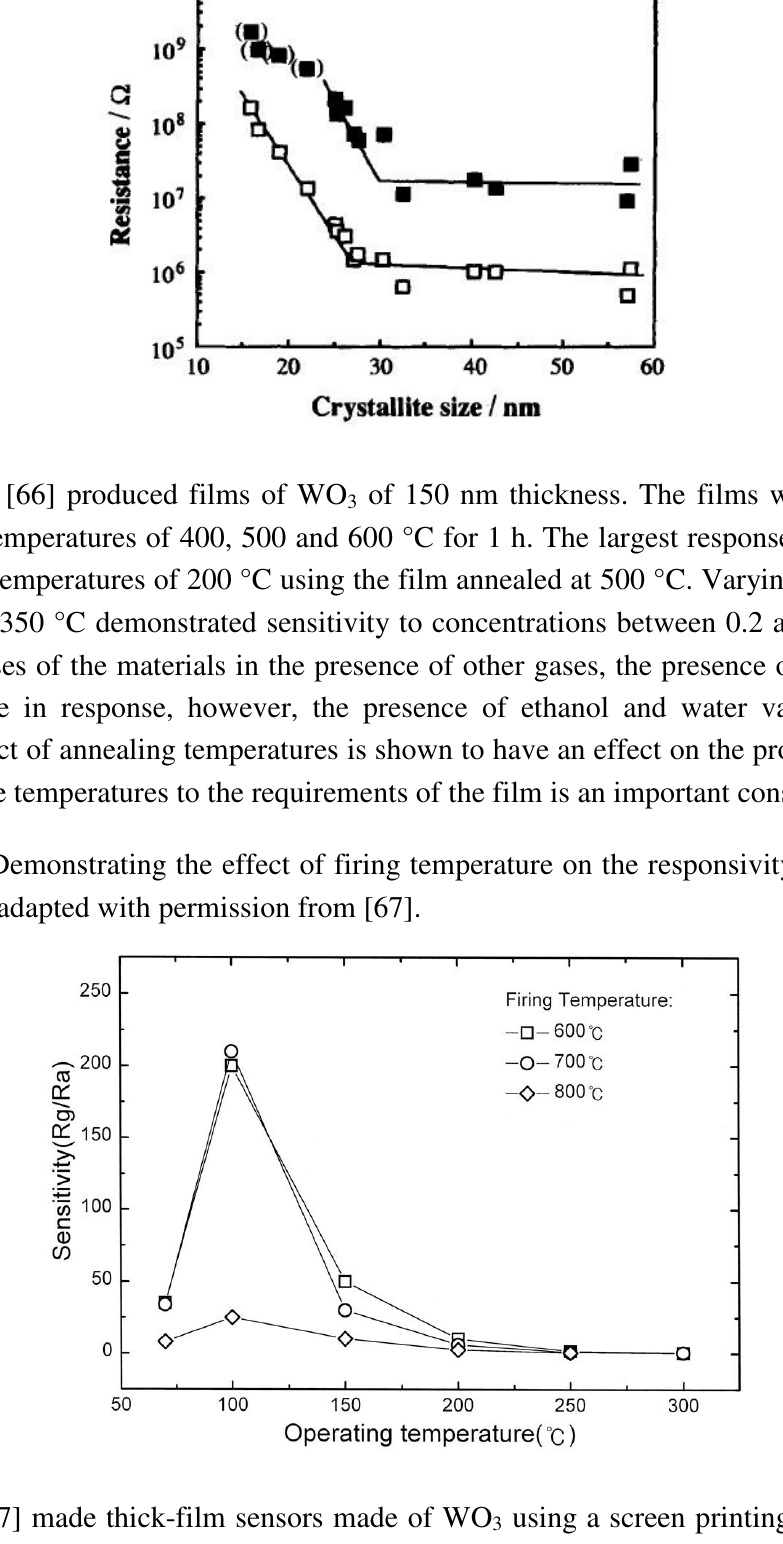
crystallite size for; (cid:1) air, and 3